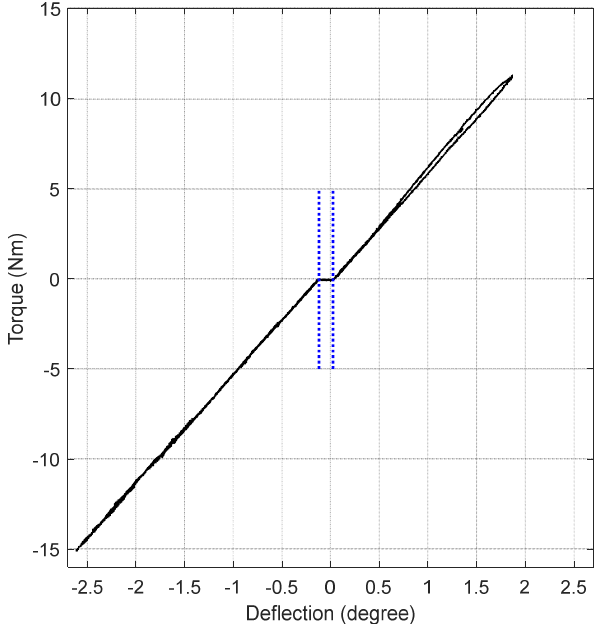
Figure 3. Linearity of spring embedded in gears. The motor angular position can be accurately controlled to follow θ md based on the position control method. In Angel Joint v1, a proportional-integral-derivative(PID) controller (see (b) in Figure 4) and an impedance compensator (see (d) in Figure 4) are implemented for position control. The PID controller gains are changed according to the magnitude of the torque error (see (c) in Figure 4). Once the motor is accurately controlled, the spring deflection is accurately controlled, which implies the accurate control of assistive torque.